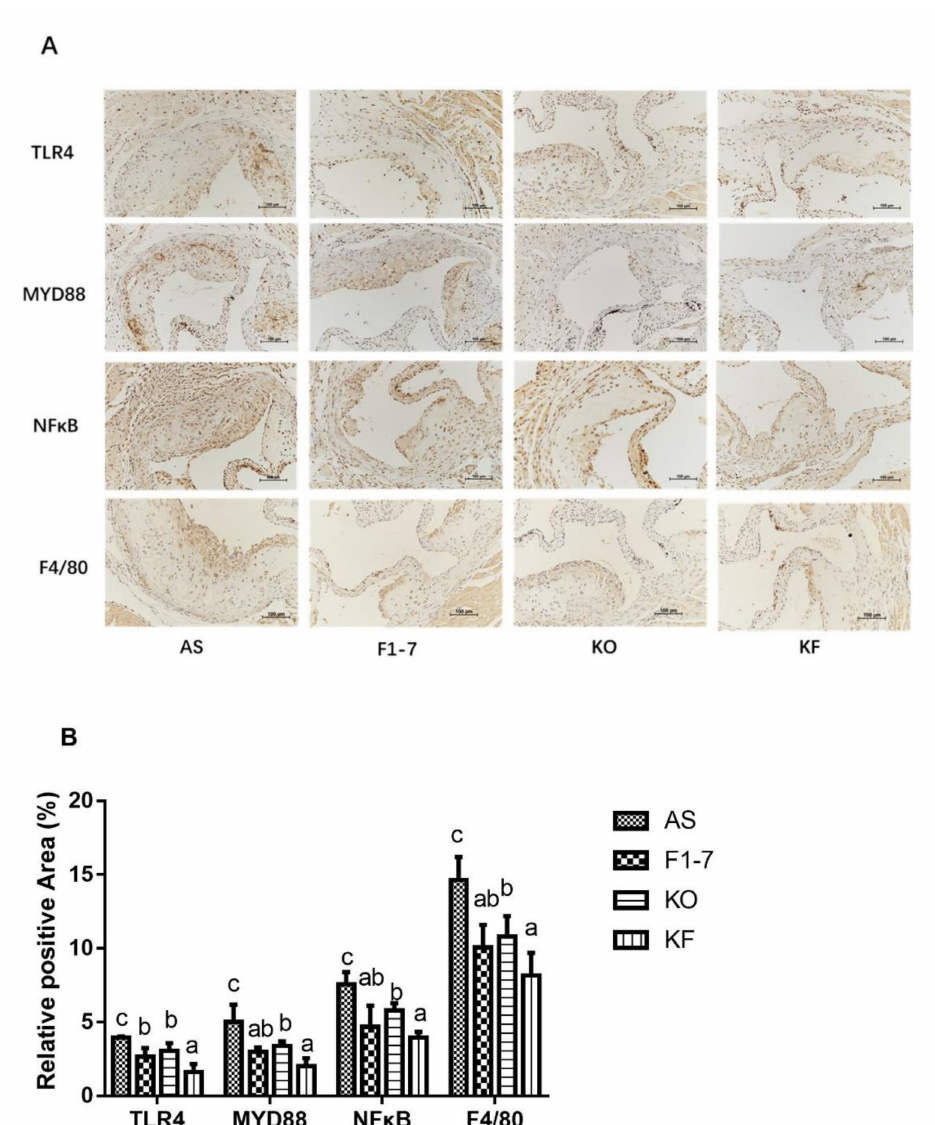
Figure 7. ( A ) TLR4, MYD88, NF κ B, and F4/80 immunohistochemistry staining of the aortic sinus in atherosclerotic mice (n = 4), and ( B ) quantitative analysis of TLR4, MYD88, NF κ B, and F4/80. Scale bar, 100 µ m. Different letters indicate significant differences, p <